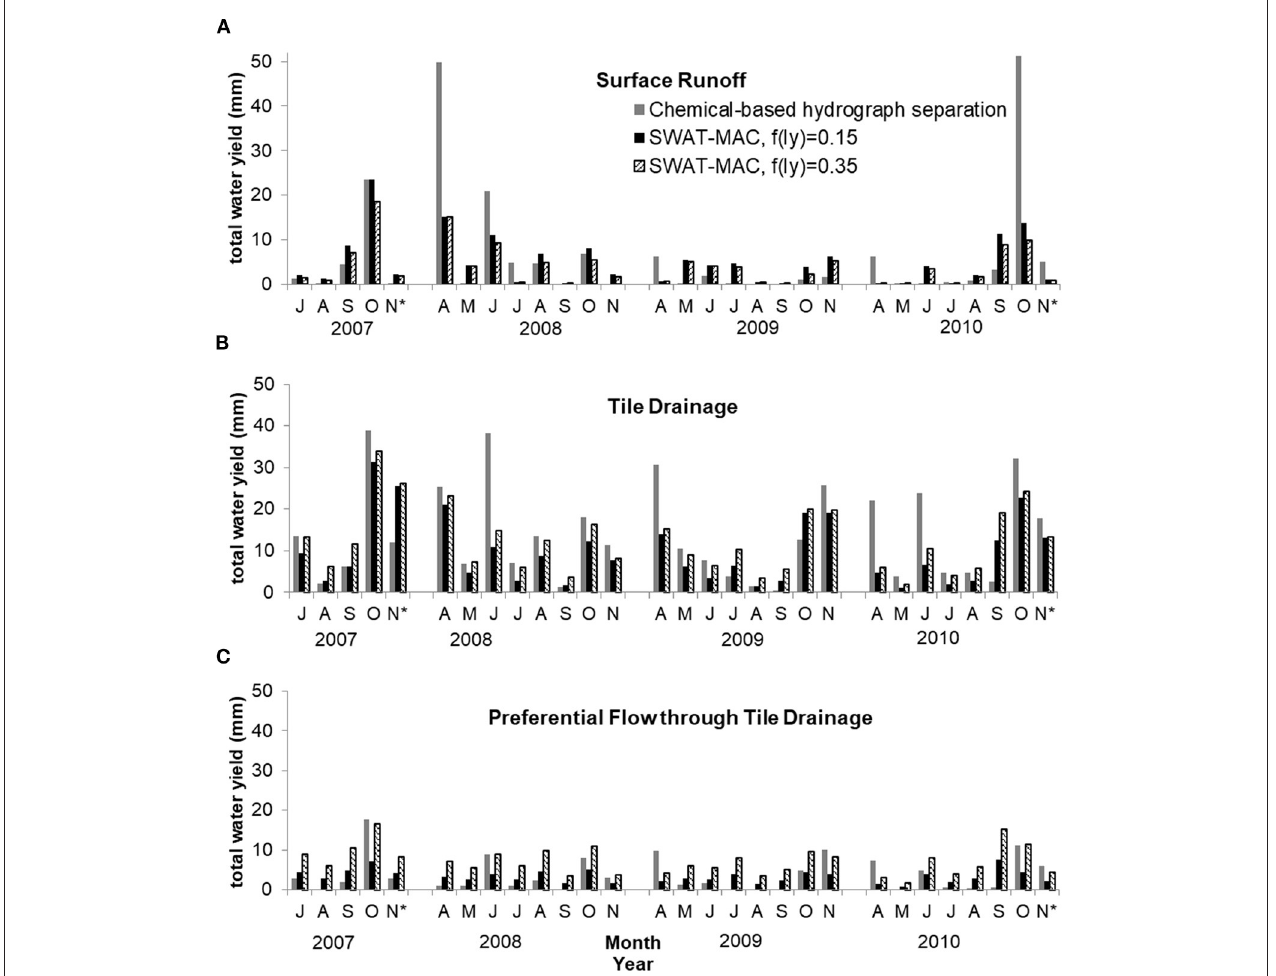
FIGURE 3 | Monthly water level (mm) in streamflow originating from in-field hydrologic sources in the Ewing subwatershed, partitioned into (A) surface runoff, (B) tile drainage, and (C) preferential flow through tile drainage. The preferential flow was assumed to be water moving through macropores. Monthly data estimated from a four-component hydrograph separation model is plotted along with predictions from SWAT-MAC using f ly = 0.15 and f ly = 0.35 as the macropore connectivity factor ( f ly ). Asterisks (*) indicate months for which the last week of results were not